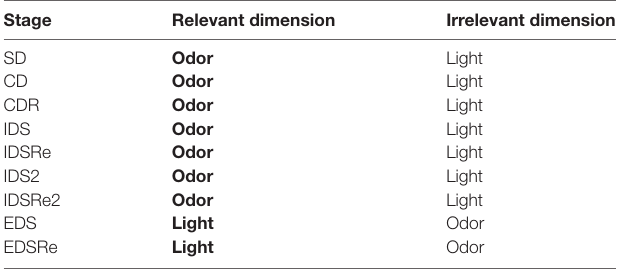
TABLE 1 | An example of the order of discriminations presented to the mice in the attentional set shifting automated